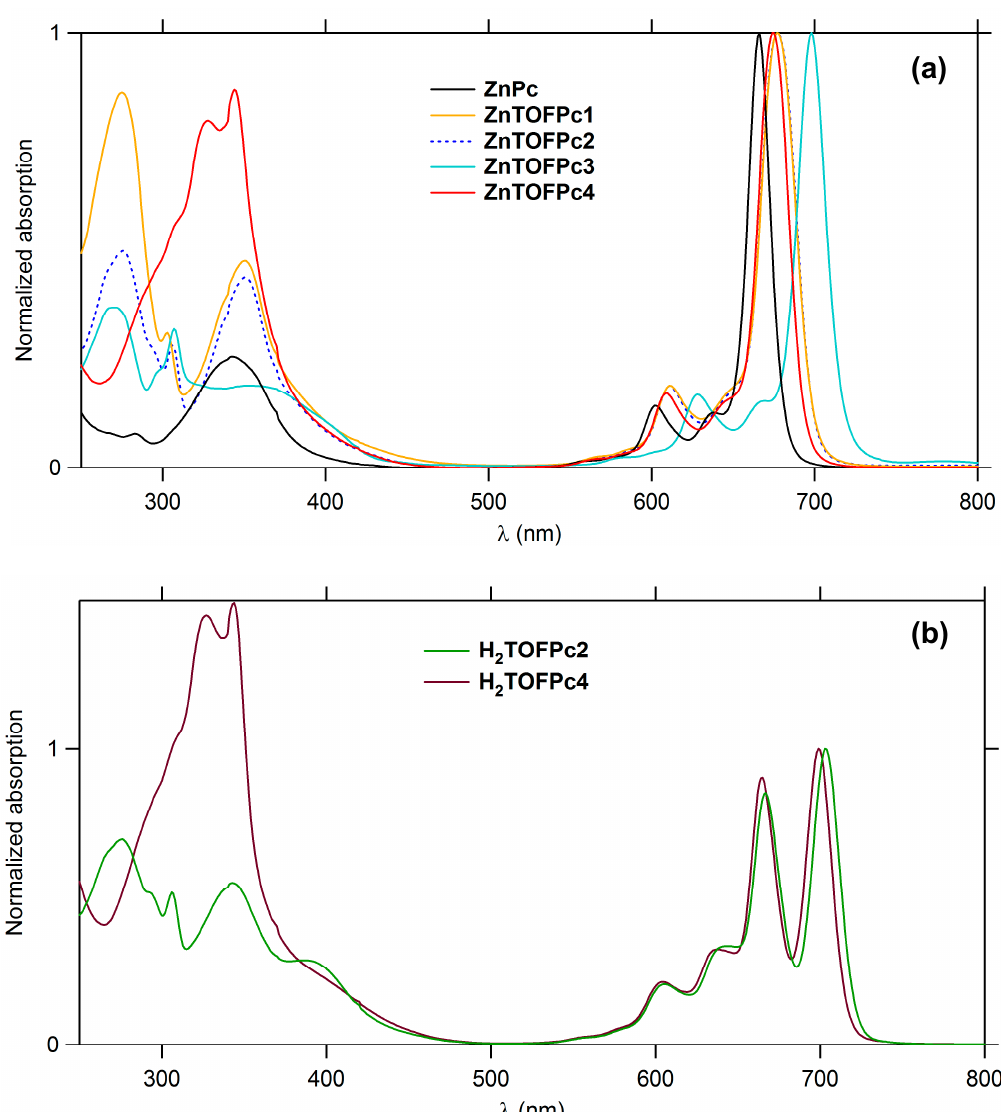
Figure 7. UV/Vis absorption spectra of the various phthalocyanine derivatives in THF at 20 °C: ( a ) Figure 7. UV / Vis absorption spectra of the various phthalocyanine derivatives in THF at 20 ◦ C: ZnTOFPc1 – 4 , and ZnPc used as reference; ( b ) H 2 TOFPc2 and H 2 TOFPc4 . ( a ) ZnTOFPc1 – 4 , and ZnPc used as reference; ( b ) H 2 TOFPc2 and H 2 TOFPc4